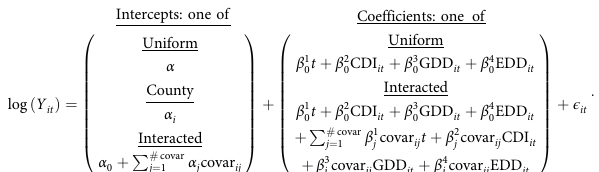
combinations from the following intercepts and coef fi cients columns, according to the table header in Table 1: